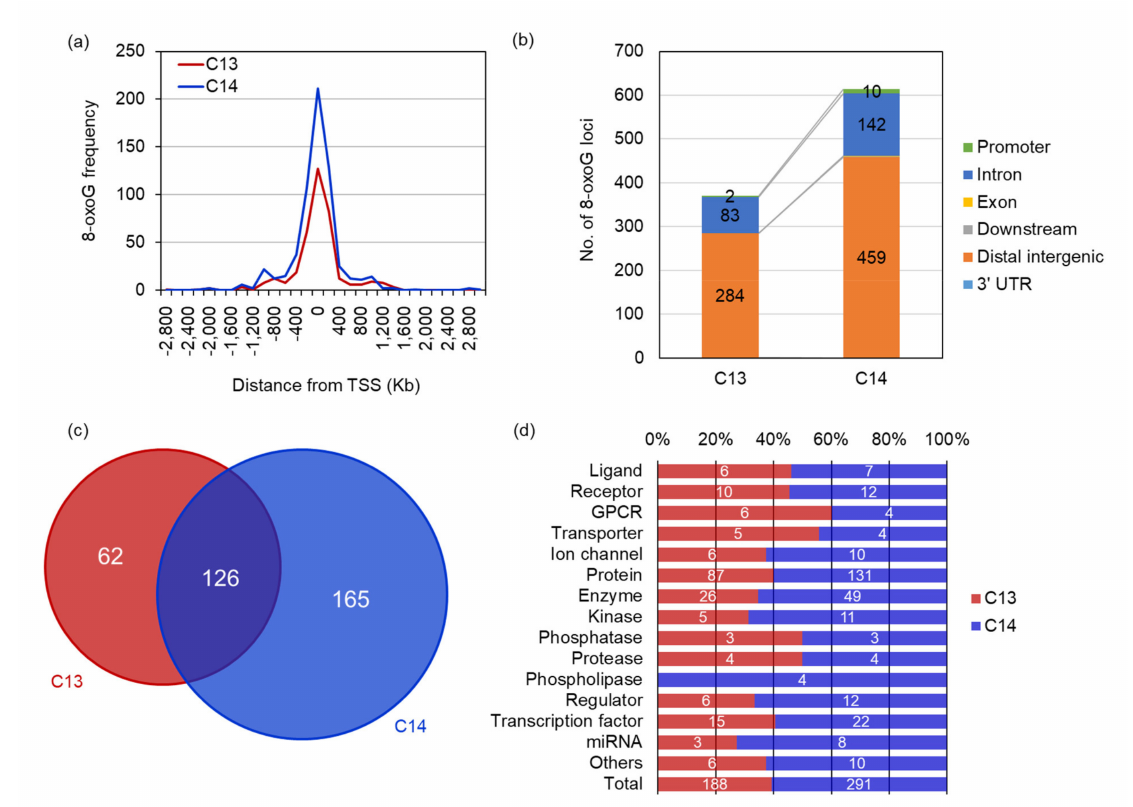
Figure 3. Increased number of 8-oxoG loci in C14 sperm DNA. ( a ) Distance of 8-oxoG loci from transcription start site (TSS). The vertical axis indicates the frequency of 8-oxoG loci for each bin of genomic distance from TSS. The red line represents C13 sperm and the blue line for C14 sperm. ( b ) Comparative genomic distribution of 8-oxoG loci of C13 and C14 sperm. Each color in the stacked graph represents from promoter (green) to 3 (cid:48) UTR region (light blue). Numbers in the graph indicate the number of 8-oxoG loci in each genomic element. ( c ) Venn diagram of sperm genes harboring 8-oxoG. The red circle indicates the number of C13 sperm genes containing 8-oxoG and the blue circle for C14 sperm genes. ( d ) Protein annotation encoded by 8-oxoG genes. The red bar represents the C13 sperm proteins and the blue bar for the C14 sperm proteins. The number in the bar represents the number of the protein encoded by 8-oxoG genes. The ratio of the total 8-oxoG genes of C13 and C14 sperm is shown